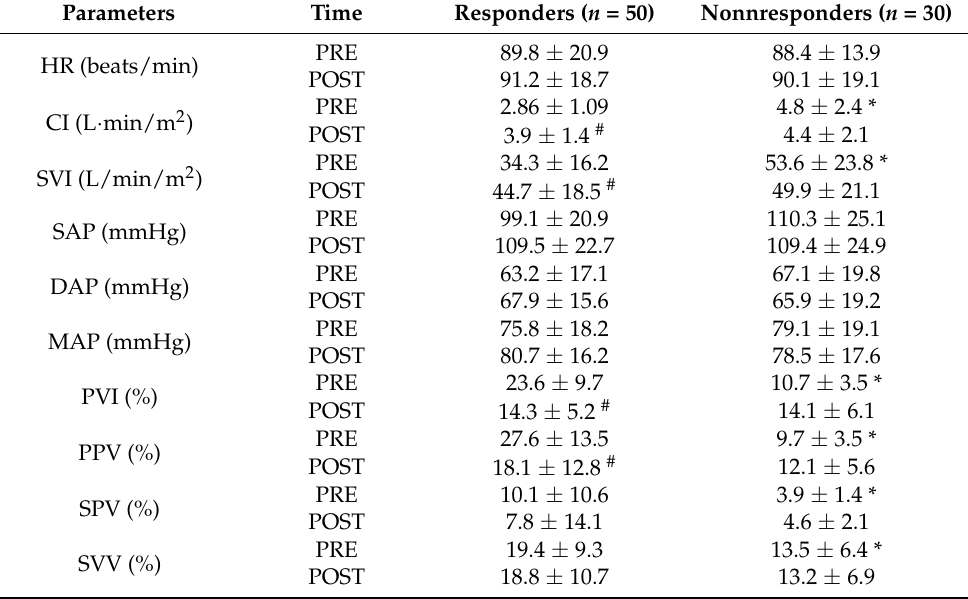
Table 2. Mean ± standard deviation of cardiovascular parameters recorded from 80 dogs under general anaesthesia and mechanically ventilated before (PRE) and after (POST) a fluid challenge of 5 mL/kg of Ringer’s lactate solution within 5 min. Responders (Rs) were dogs that had a CI increase ≥ 15% POST compared with PRE, whereas the rest of the population was classified as nonresponders